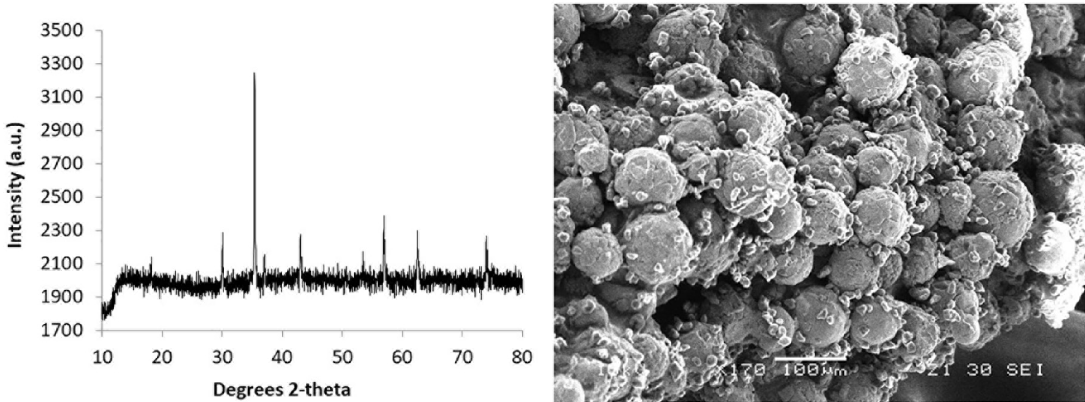
Figure 3. XRD patterns (left) and SEM images of 3-D particles arrays